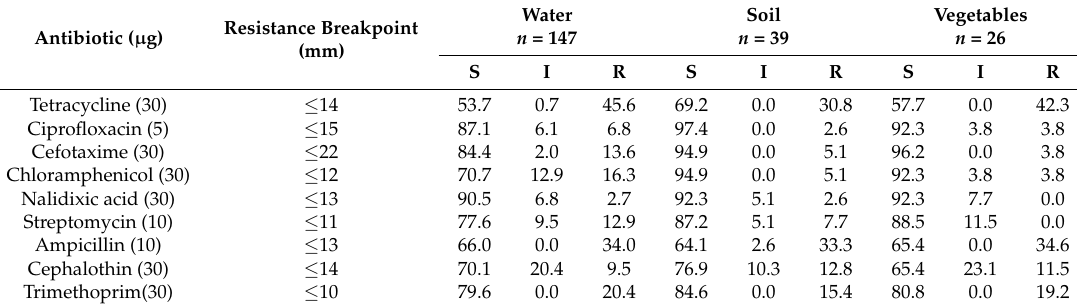
Table 1. Percentages of E. coli isolates from agricultural irrigation water in Metro Manila, Philippines that were susceptible (S), intermediate (I) and resistant (R) to antibiotics. Resistance breakpoints were based on CLSI standards.